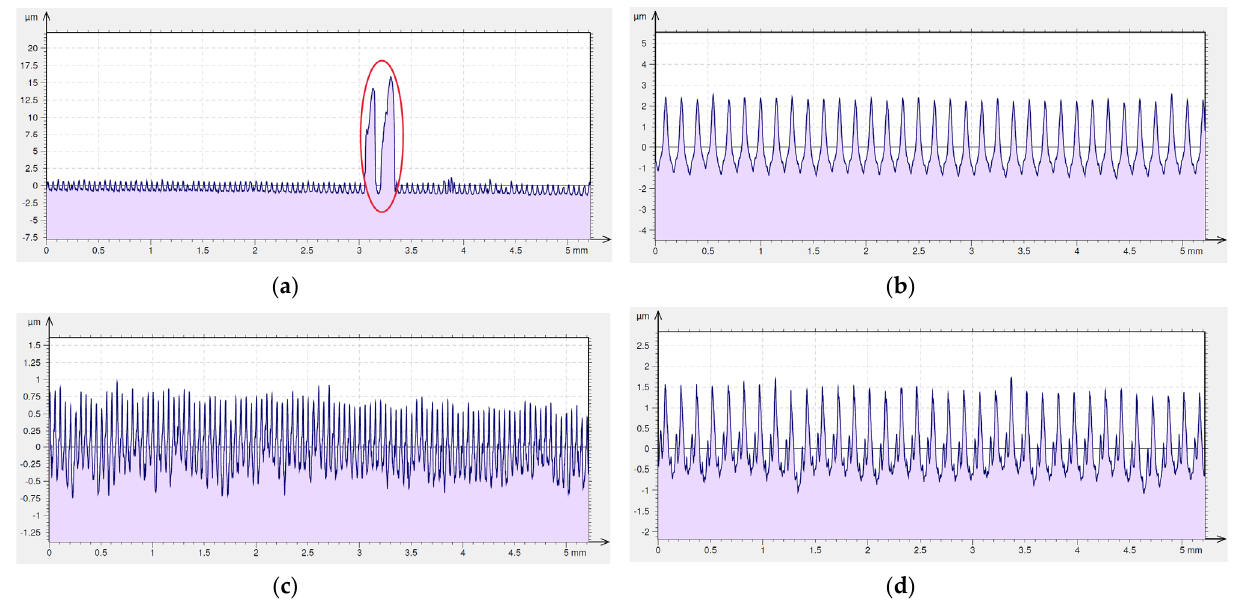
Figure 16. Surface roughness profile of Inconel 718 after turning by conventional insert (the sticking on machined surface is marked by red circle). ( a ) dry cutting, f = 0.05 mm/rev; ( b ) dry cutting, f = 0.15 mm/rev; ( c ) wet cutting, f = 0.05 mm/rev; ( d ) wet cutting, f = 0.15 mm/rev.